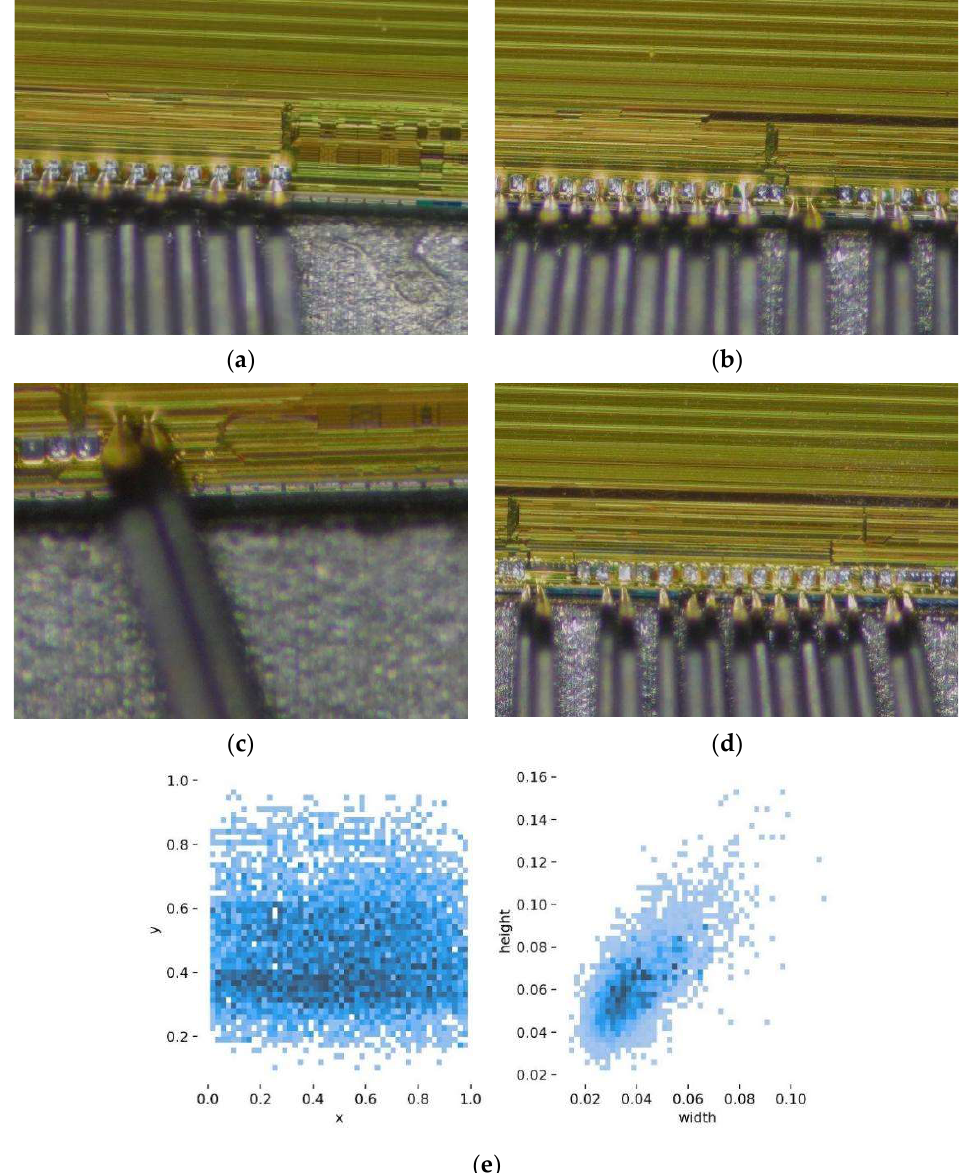
Figure 1. Wafer Solder Joint Dataset. ( a , b ) Sample image contains chip pad A; ( c ) Sample image contains chip pad B; ( d ) Sample image contains chip pad A and chip pad B; ( e ) Target frame distribution.